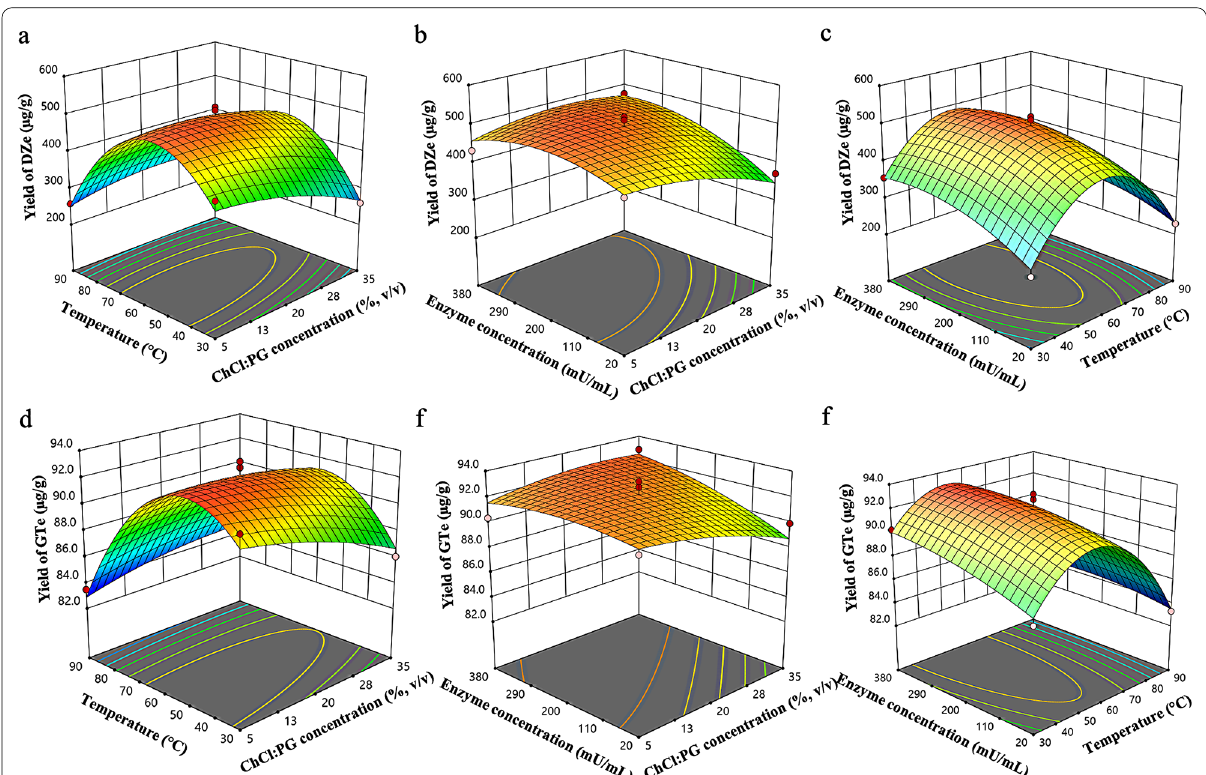
Fig. 4 3D plots of the responses of DZe ( Y 1 ) ( a – c ) and GTe ( Y 2 ) ( d – f ), demonstrating the effect of interaction between independent factors, including NADES concentration ( X